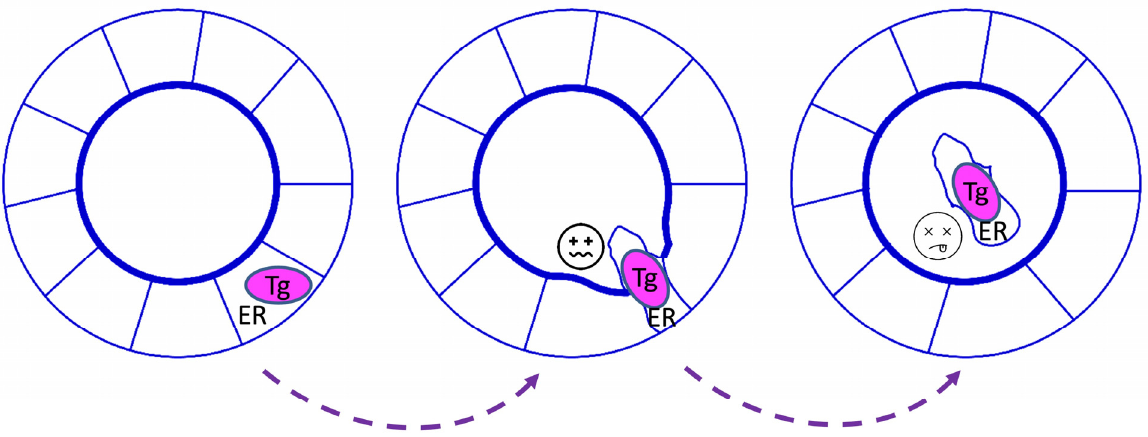
Figure 3. The mechanism of thyroid hormones synthesis in hypothyroidism with defective thyroglobulin. Thyrocytes under massive ER stress ( left ) lose epithelial cell-cell contact, likely from diminished cell junctional integrity, and progress to cell death ( right ). Dying thyrocytes that have been extruded into the follicle lumen eventually disintegrate and their macromolecular components are exposed to iodination and ingestion by surrounding live thyrocytes.